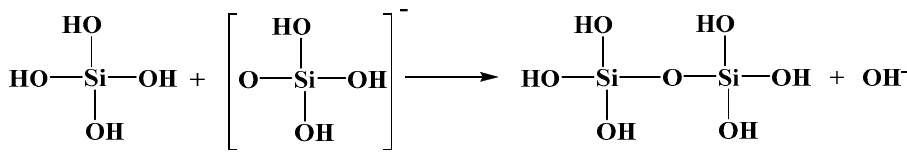
Figure 6. The polymerization reaction between Si(OH) 4 and H 3 SiO 4 − .